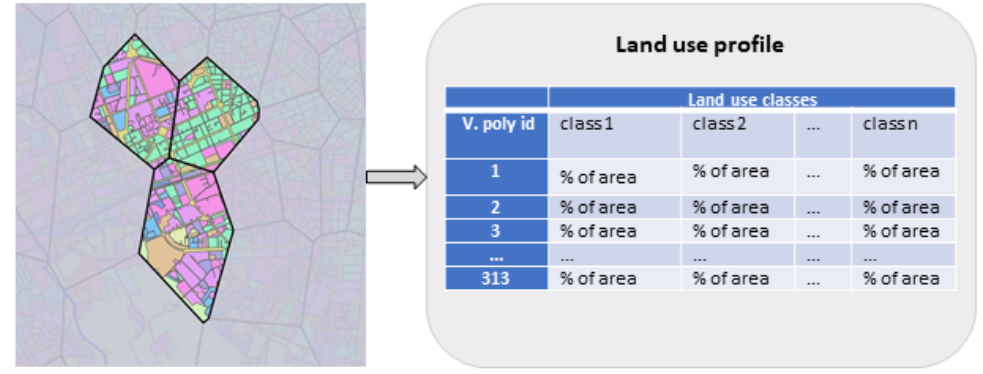
Figure 5. Example of three Voronoi polygon intersection with land use layer and Land use profile